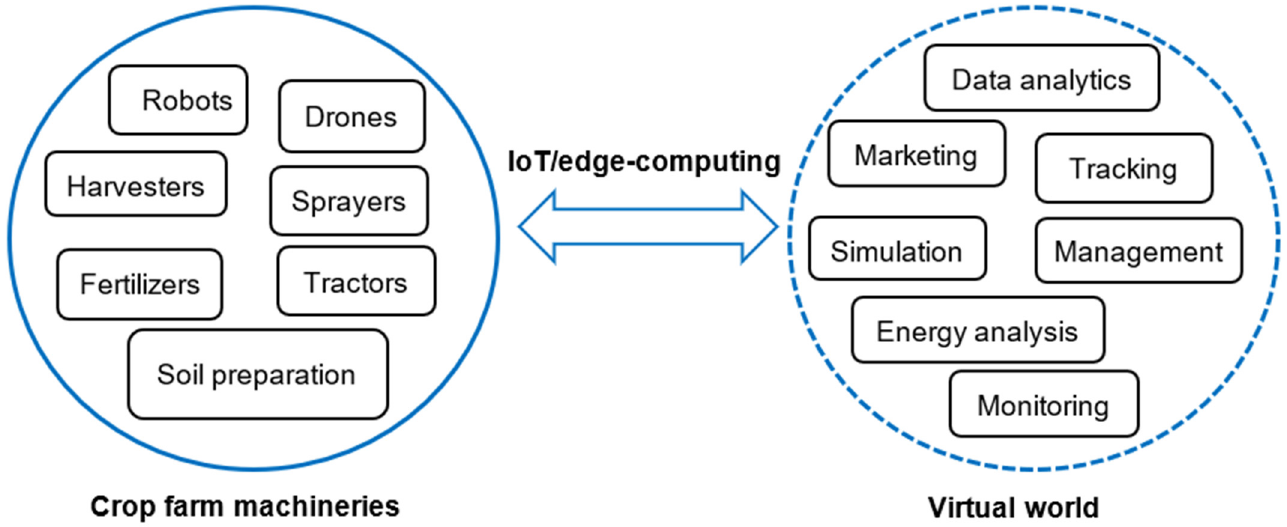
Figure 2. An architecture of the digital twin concept for crop production technology.